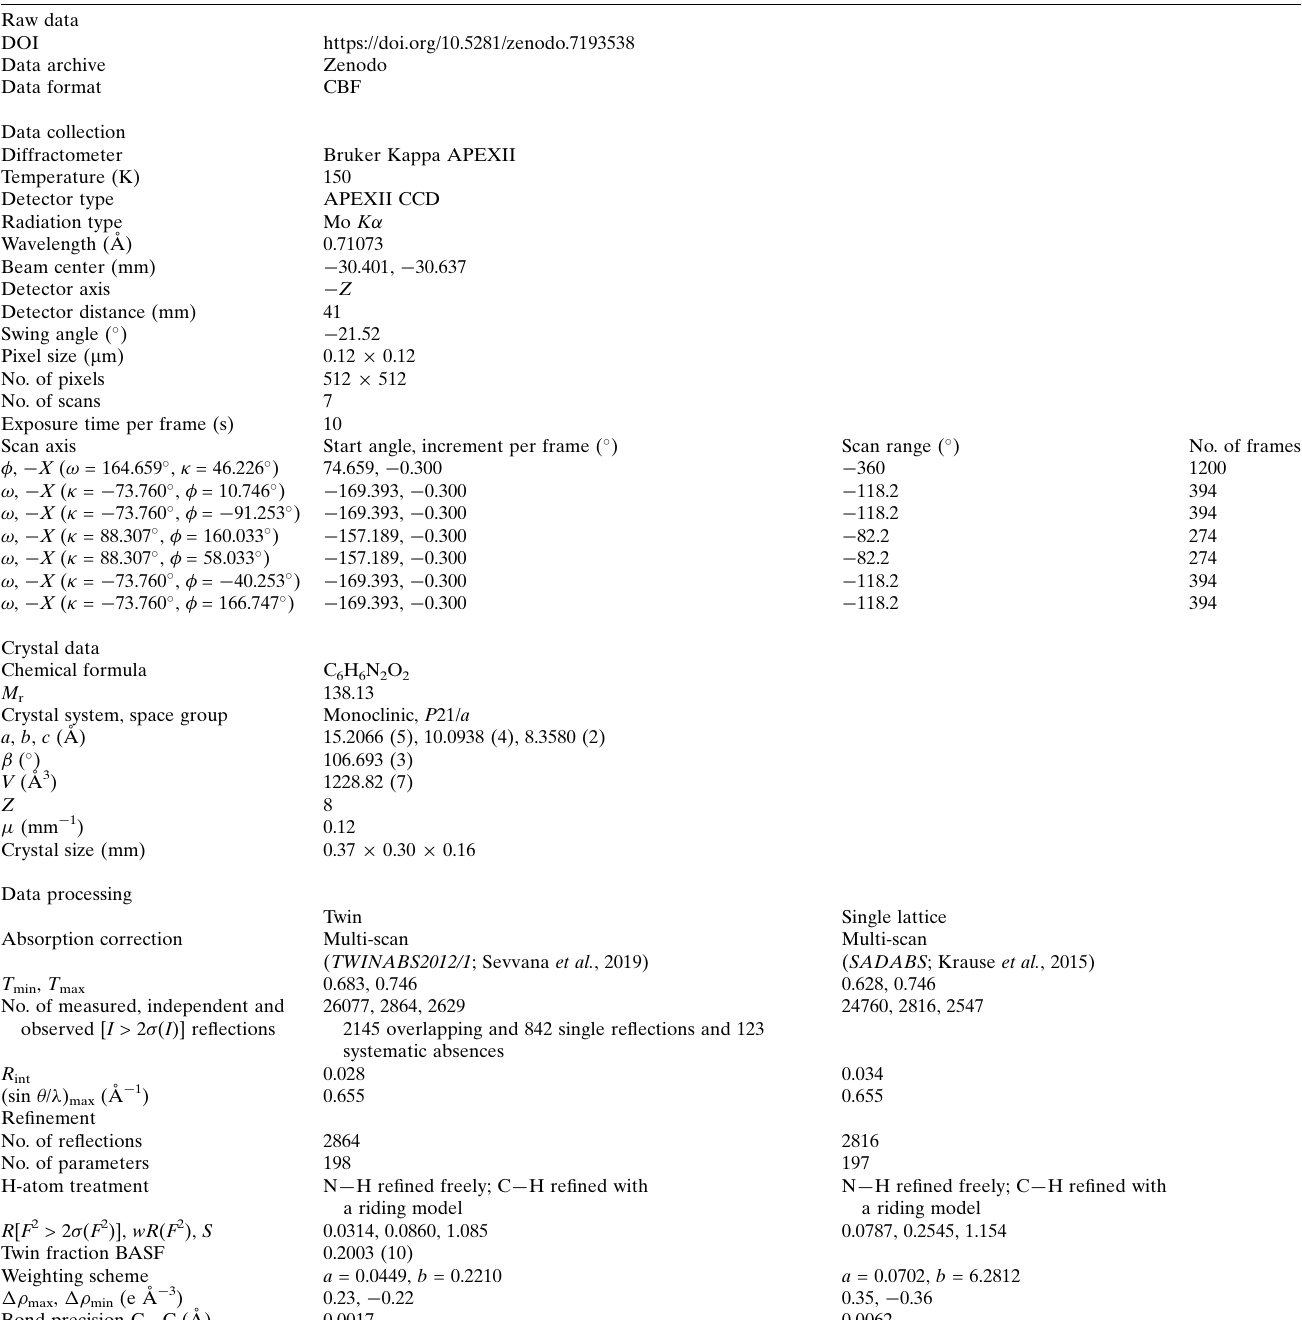
Table 1 Experimental